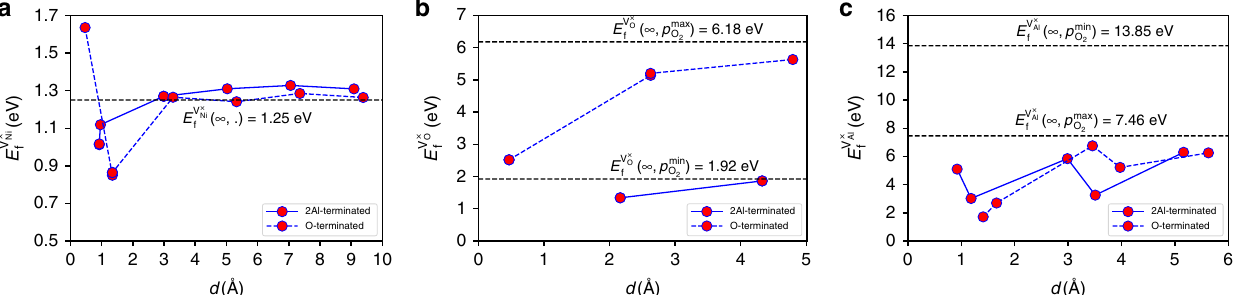
(cid:1) (cid:3) ´ ´ ´ , E V versus distance from the interface d . a Ni vacancy formation energy for both O-terminated , E V O Al Ni f f f and p min O 2 O 2